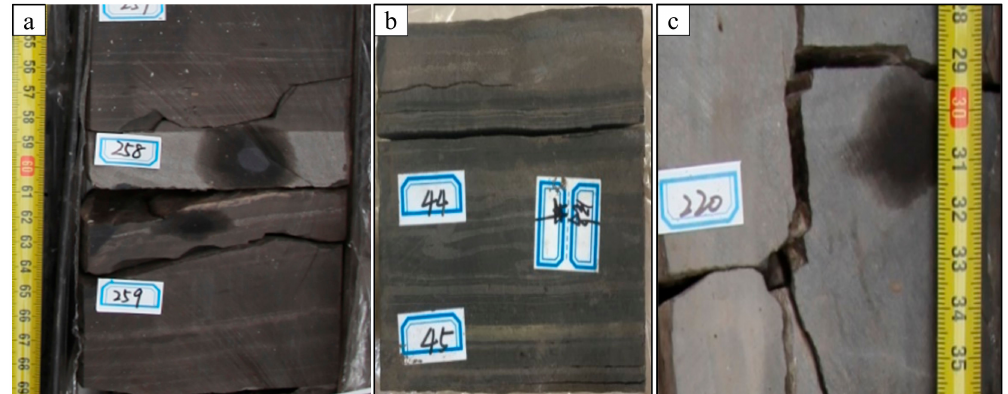
Figure 1. Downhole full diameter core: ( a ) tu ff interbeds and oil spots in shale; ( b ) siltstone interbeds and bedded microcracks in shale; ( c ) irregular structural cracks and oil spots in tu ff .